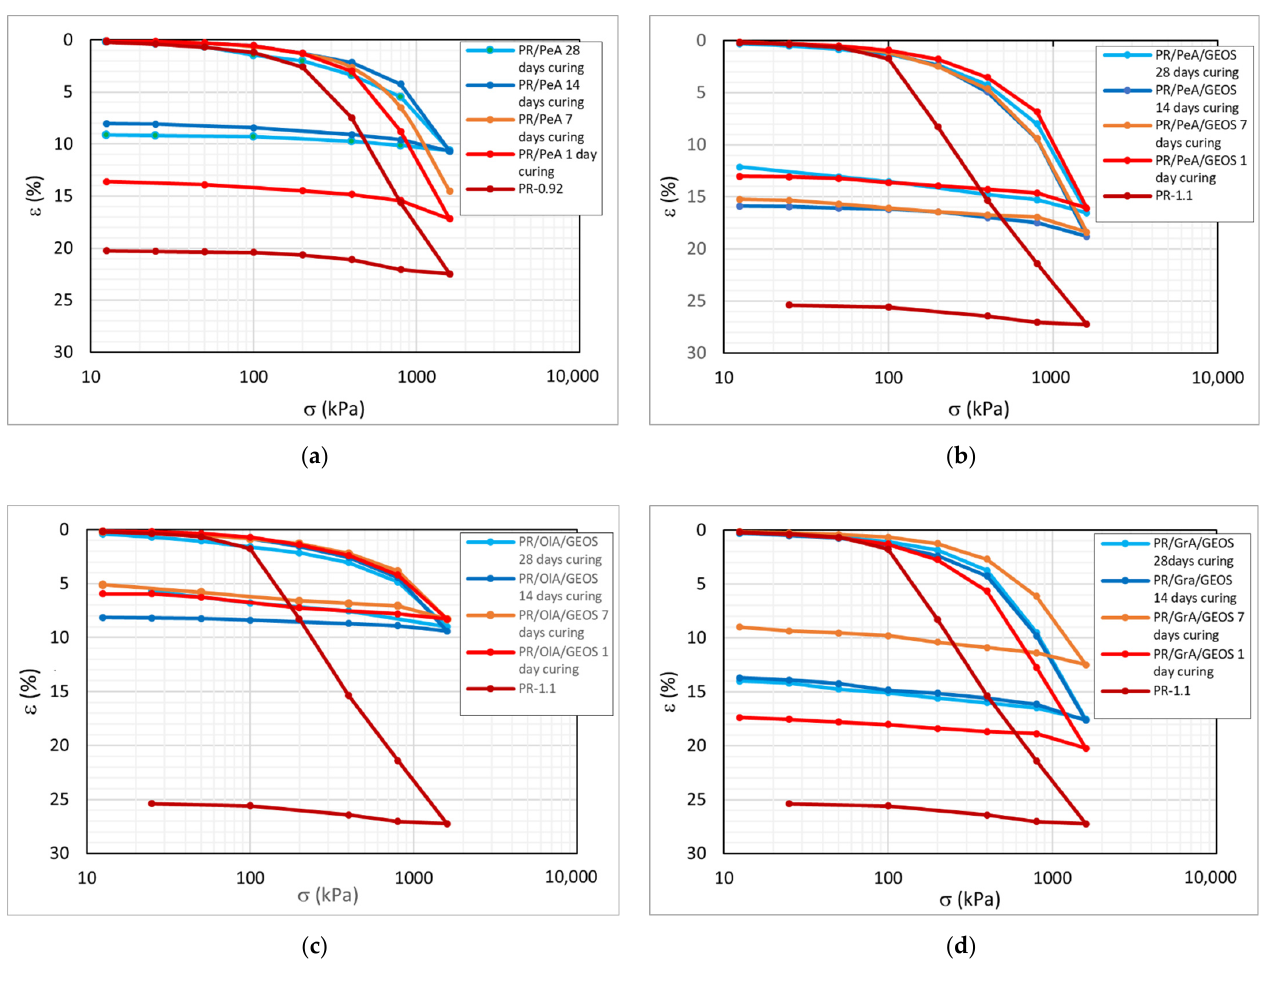
Figure 2. Compression curves of PR-0.92 and PR/PeA ( a ), PR-1. 1 and PR/PeA/GEOS ( b ), PR-1.1